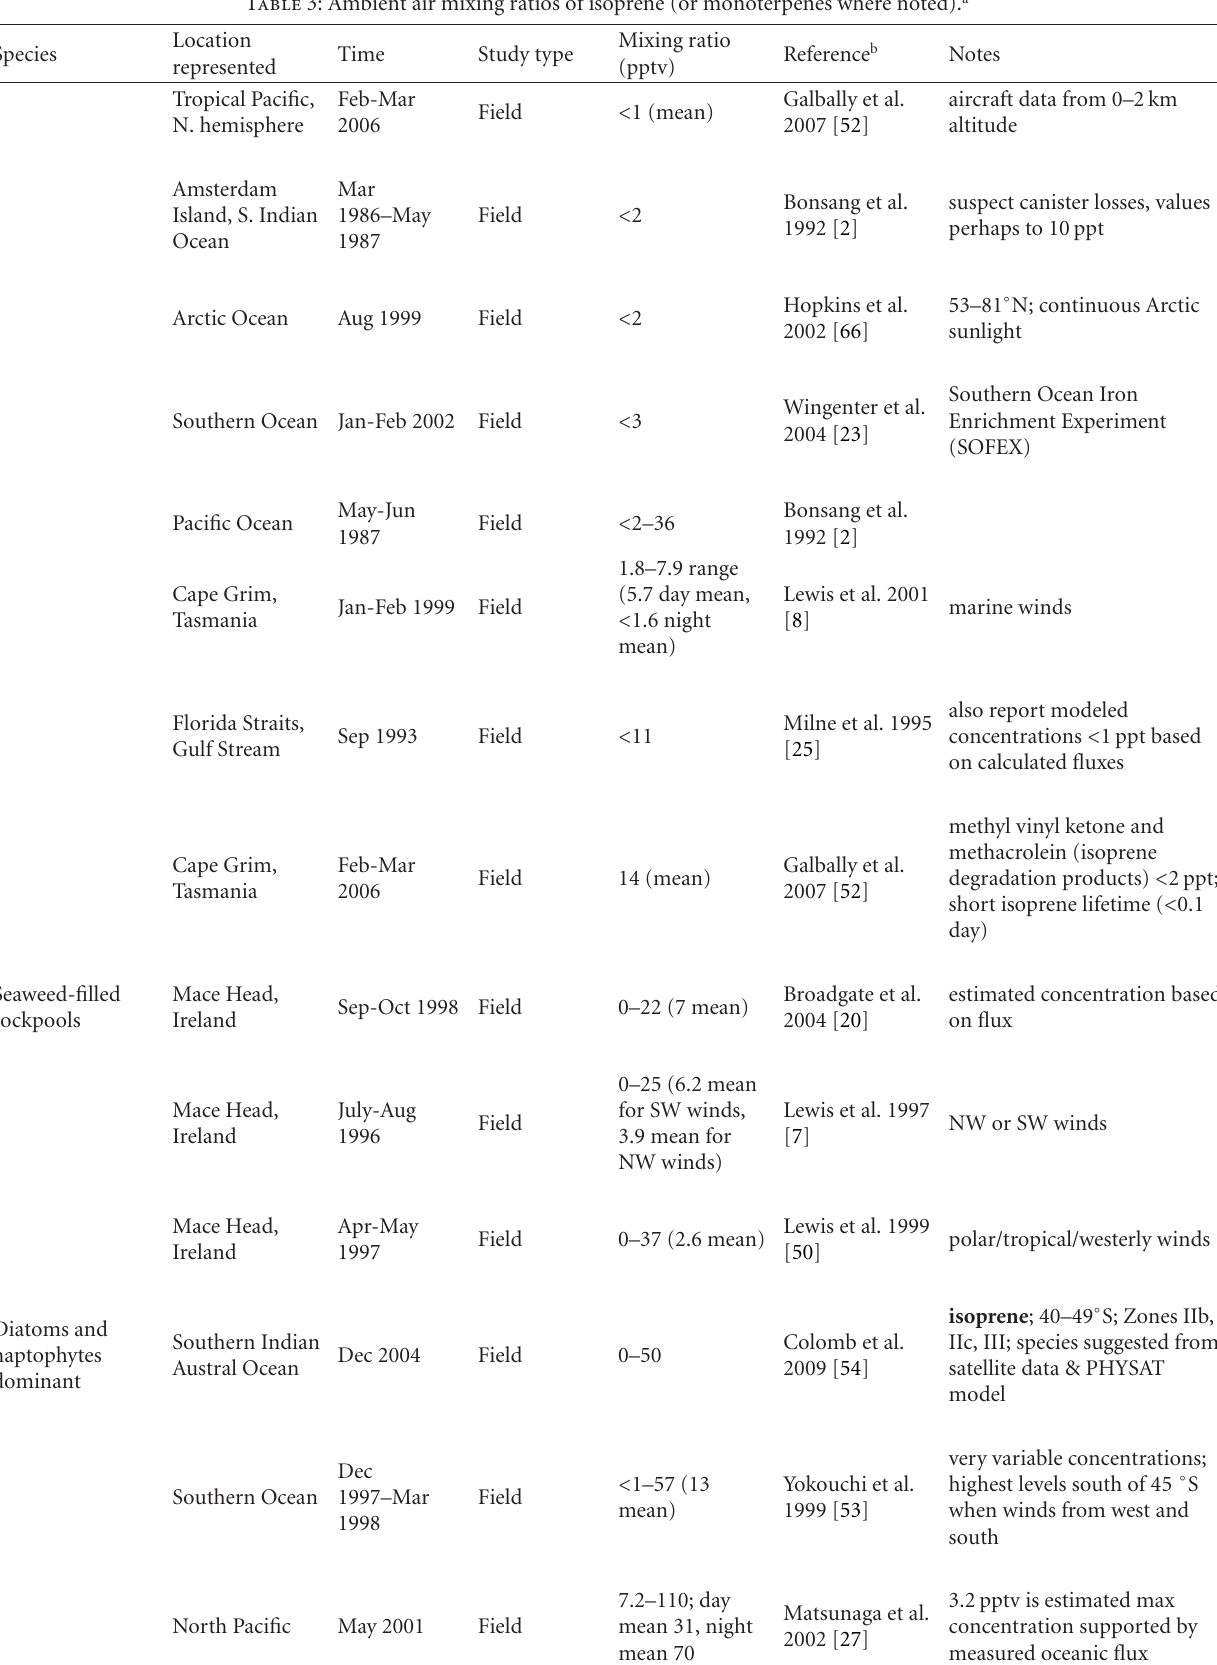
Table 3: Ambient air mixing ratios of isoprene (or monoterpenes where noted).